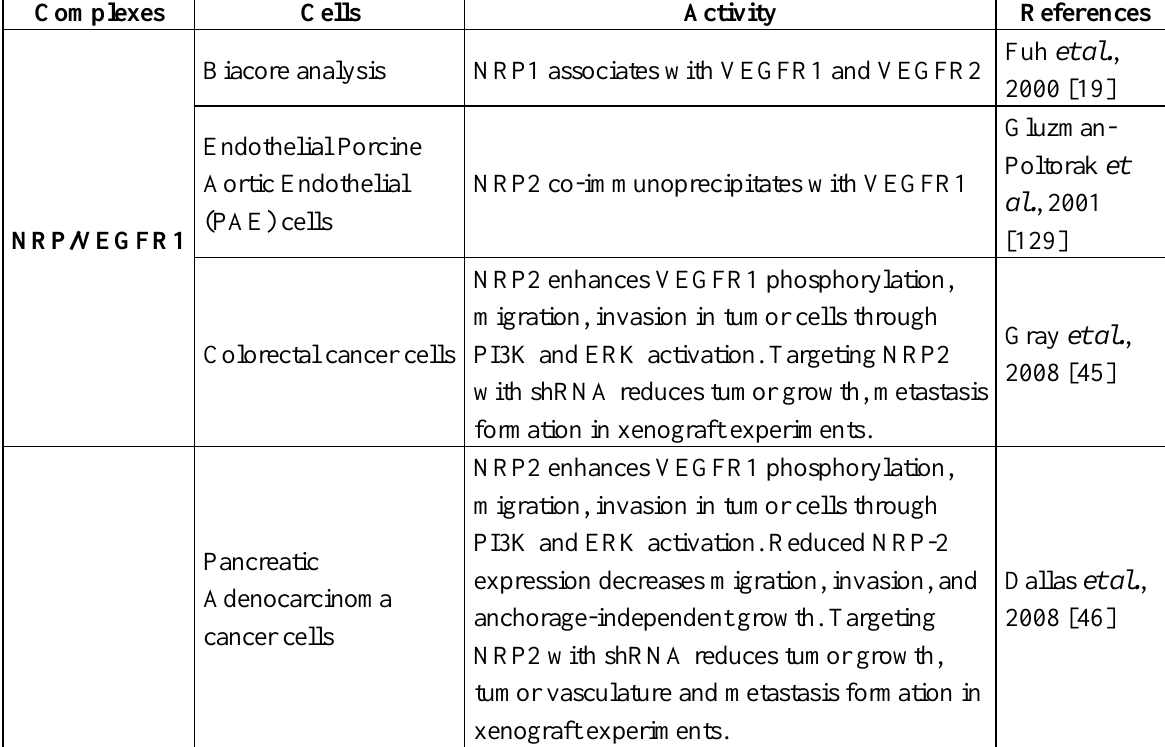
Table 3. NRPs interactions with growth factor